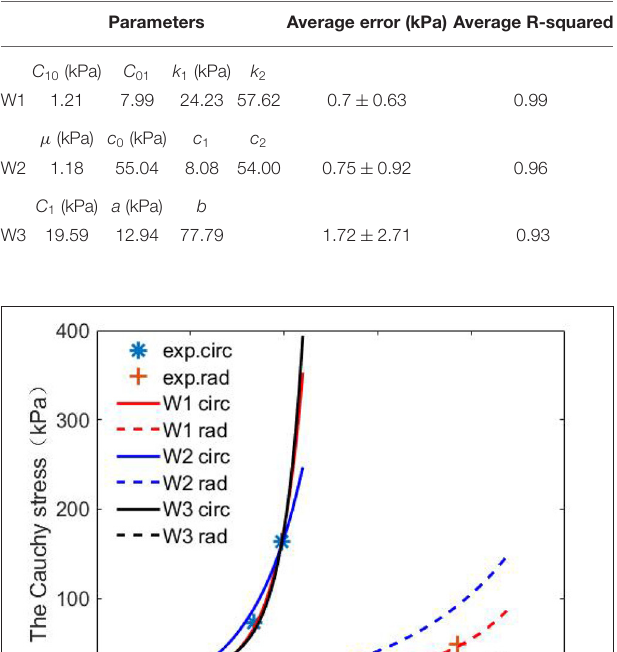
TABLE 1 | Fitted parameters for the three selected constitutive laws [Equations(10)–(12)].